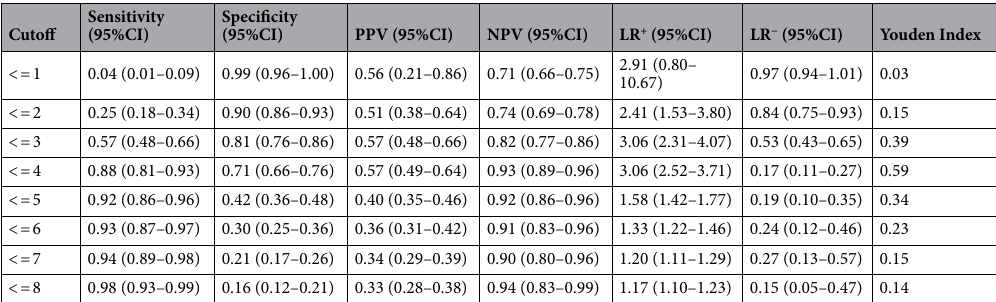
Table 4. Sensitivity, specificity, PPV, NPV, LR + , and LR − of individual dietary diversity score among PLHIV in all ART clinics of Bahir Dar,